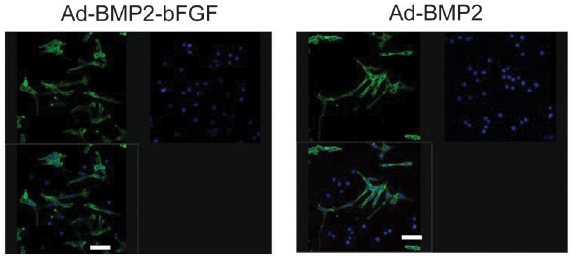
Figure 8. Immunocytochemical staining of collagen II in bone marrow progenitor cells 21 days after infection with Ad-BMP2- bFGF or Ad-BMP2. The expression of collagen II is indicated by green (upper left panels), the nuclei are indicated by blue (upper right panels), and the overlapping is shown in lower left panels. Bar = 200 m